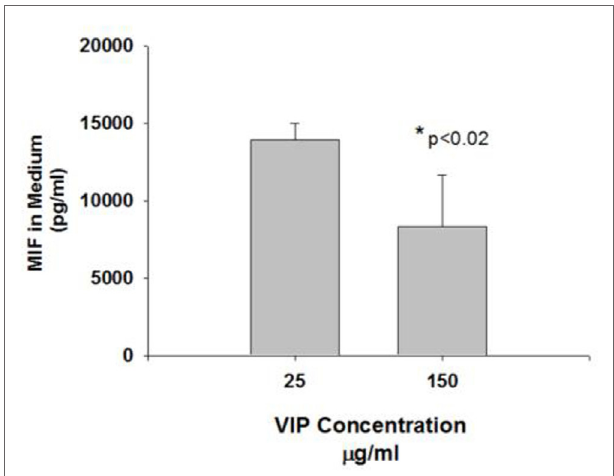
FigUre 4 | Vasoactive intestinal peptide (VIP) concentration-dependent changes to MIF in medium. The MIF concentration in the cells treated with VIP 150 mg was significantly reduced compared to controls (* p <